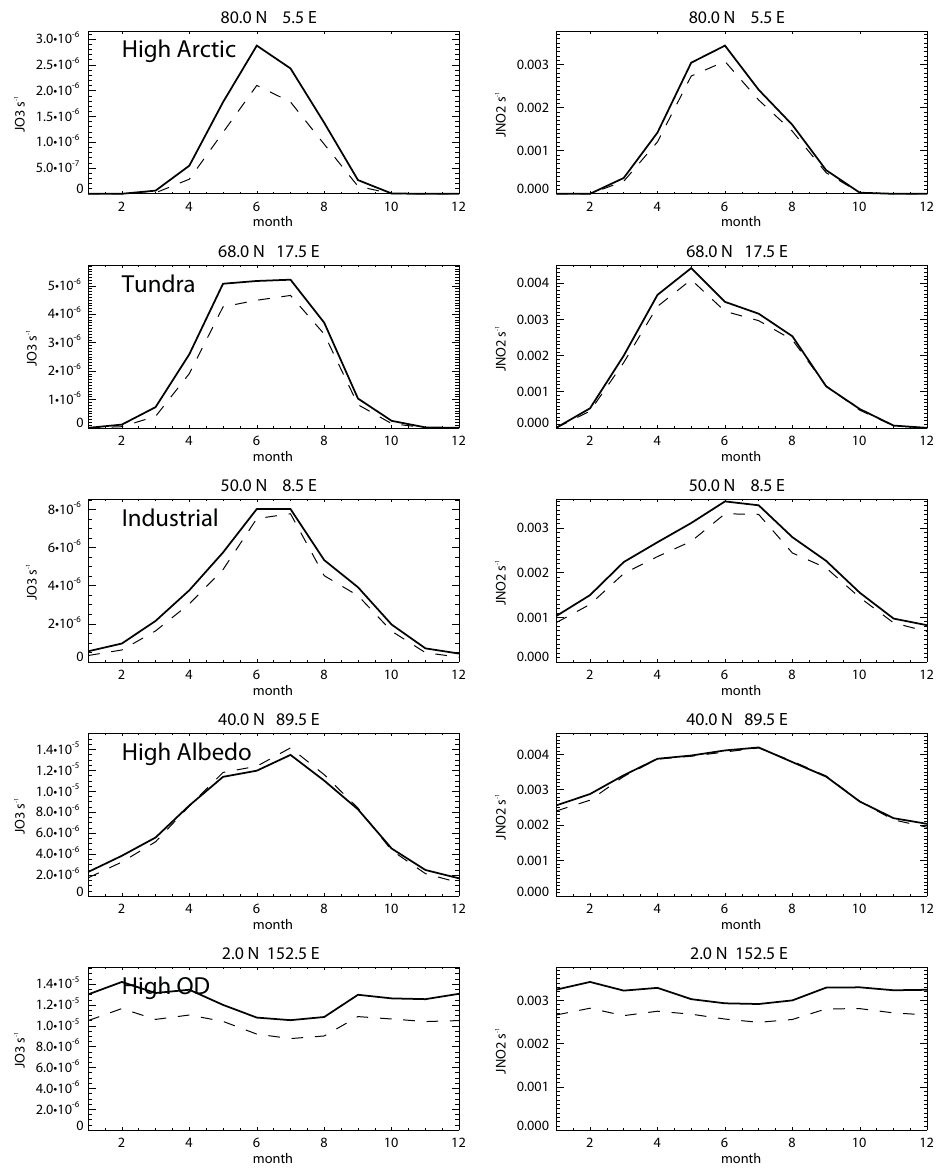
Fig. 3. The monthly mean variability of (left) J (—) and MBA ( ) . The type of grid cell at which the comparisons are made is shown in the inset of each